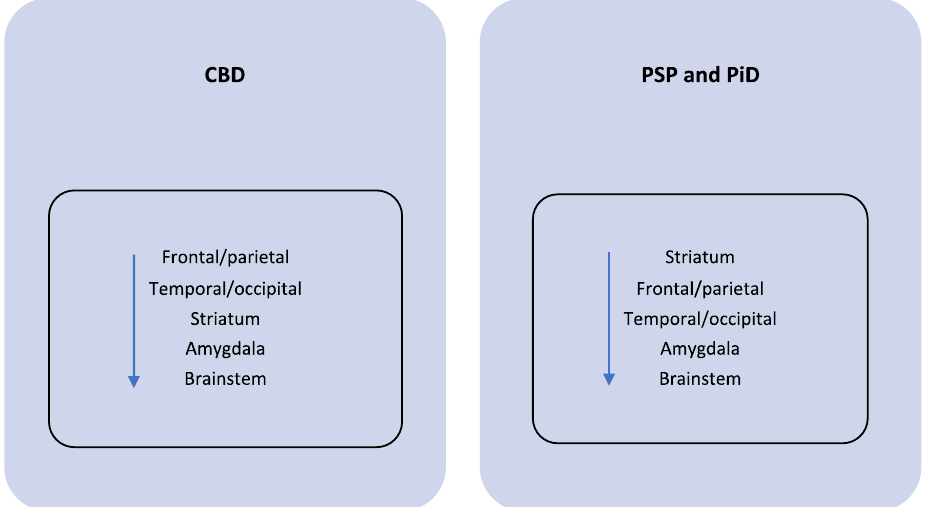
Figure 4. A simplified schematic for aging-related tau astrogliopathy (ARTAG) staging systems based on Kovacs et al. Acta Neuropathol Commun. 2018. Staging is classified according to ARTAG location- subpial, white matter, subependy- mal thorn-shaped astrocytes (TSAs) and grey matter granular/fuzzy astrocytes (GFAs) in non-frontotemporal lobar de- generation tauopathies (FTLD-tau). No distinct pattern has been identified for subependymal ARTAG. Multiple patterns of spread have been proposed for all classifications ( top panel). Basal regions = basal forebrain and amygdala; lobar regions = frontal, parietal, temporal and occipital lobes. regions = frontal, parietal, temporal and occipital